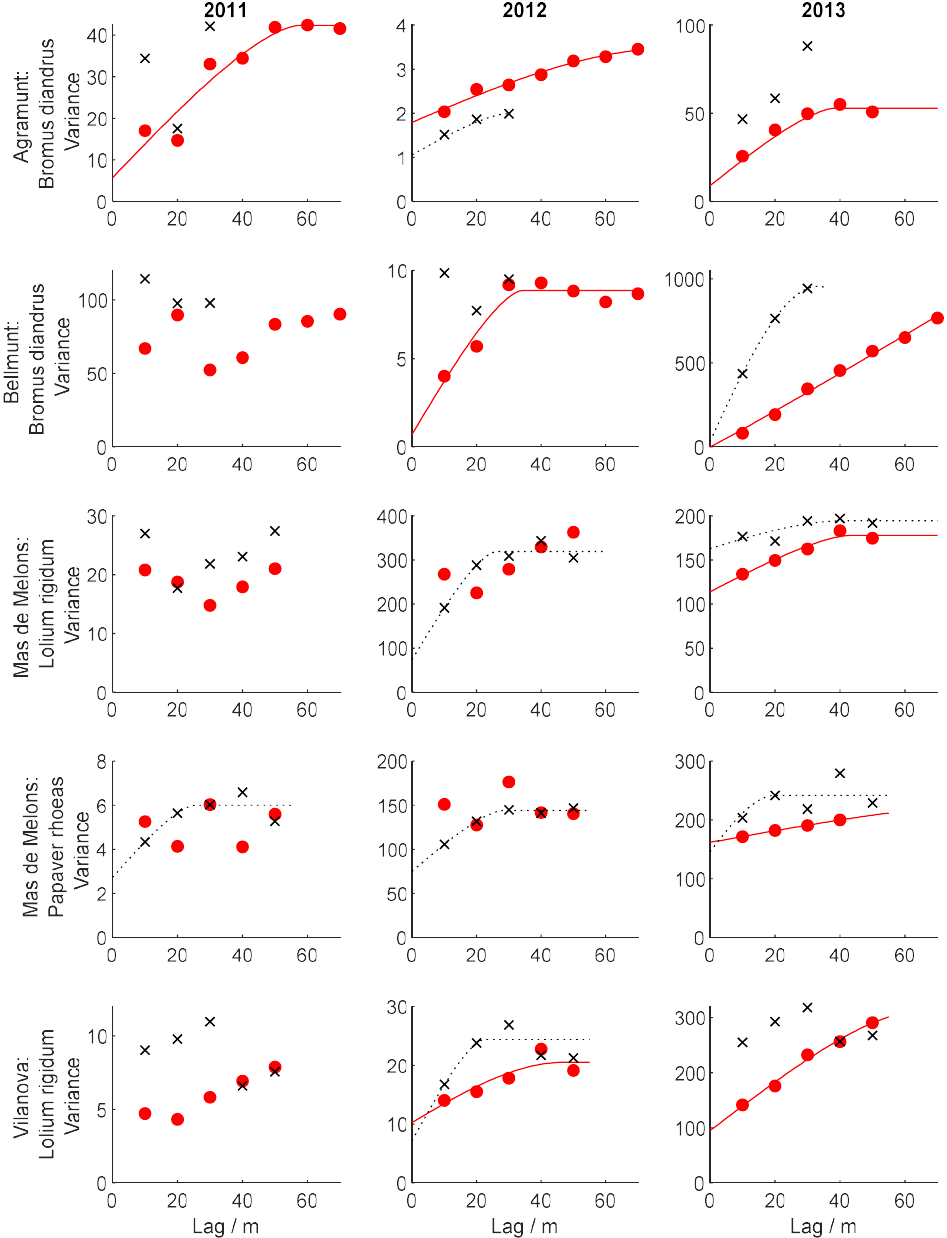
Figure 4. Empirical variograms with fitted models (solid and dotted lines) for direct-drilled sites. Variograms with lag distance in the direction of traffic are shown by the red discs, and those with lag distance perpendicular to field traffic are shown by the black crosses. The model parameters are given in Table 4. Where no line appears, a model could not be fitted.